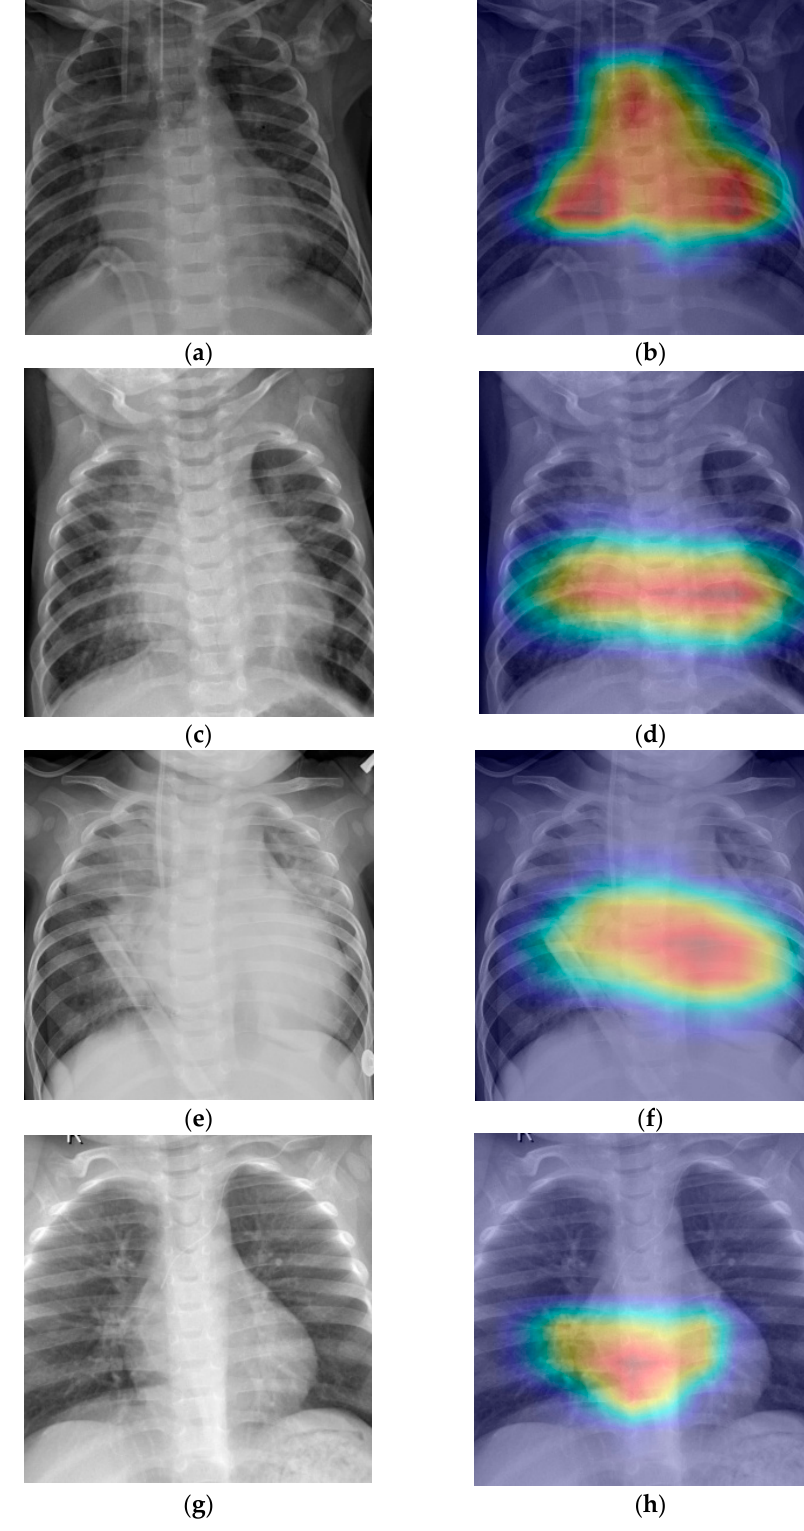
Figure 12. Heat maps for classified test examples using Grad-CAM. ( a , c , e , g ) show a preprocessed CXRAYs; ( b , d , f , g ), show their respective Grad-CAM.